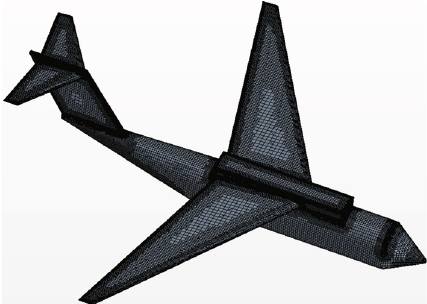
Figure 6: Mesh on the aircraft surface.